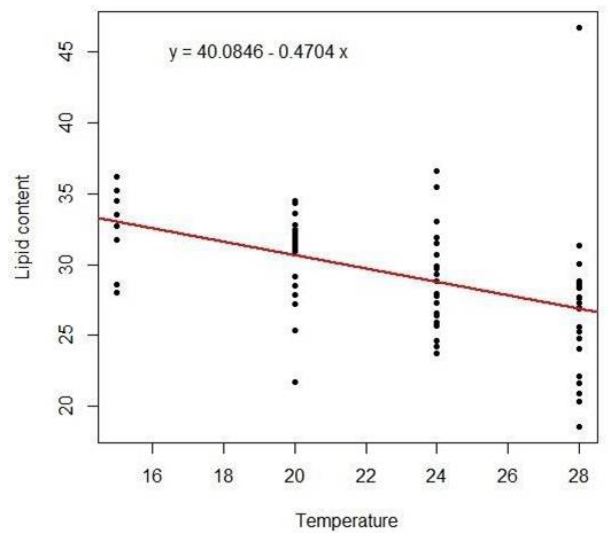
Fig 4 . Linear regression between variations in lipid content of queens and